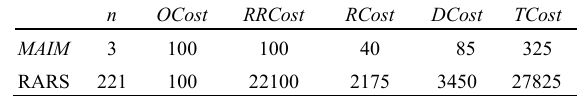
Table 3. The comparision of response number and